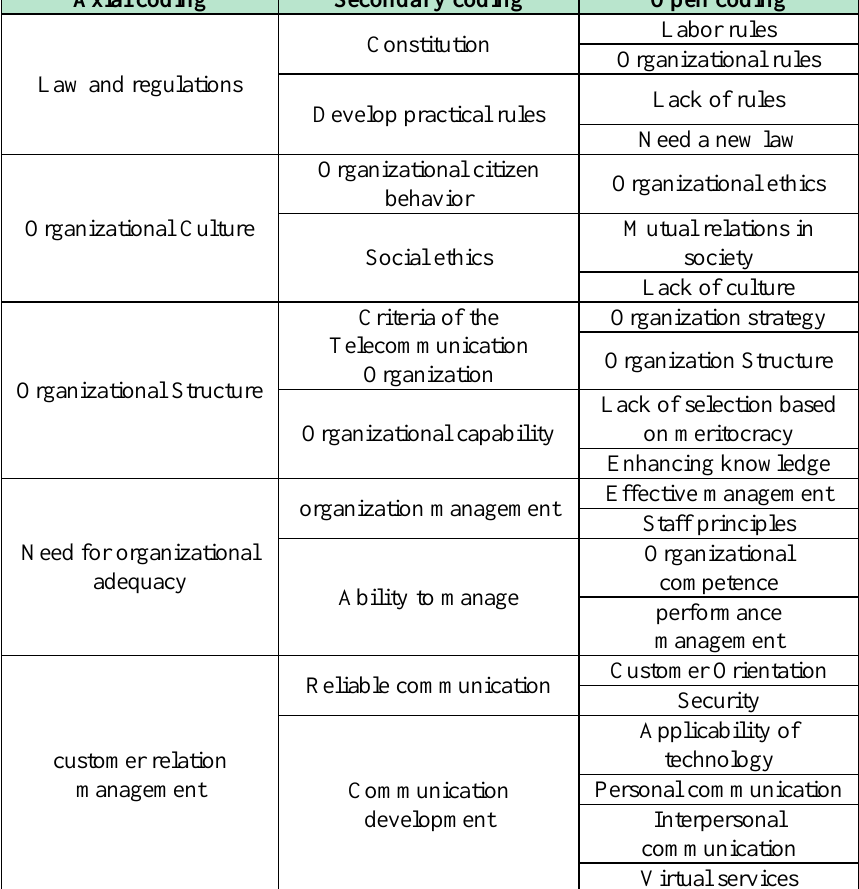
Table 1: Axial coding of qualitative data (causal